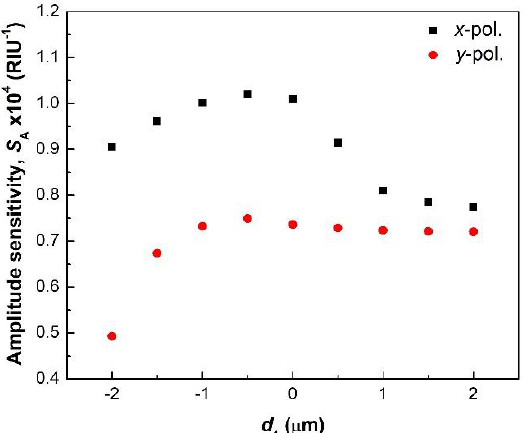
Figure 9. Amplitude sensitivity as a function of d 1 . Black points (square shape) and red points (cir-